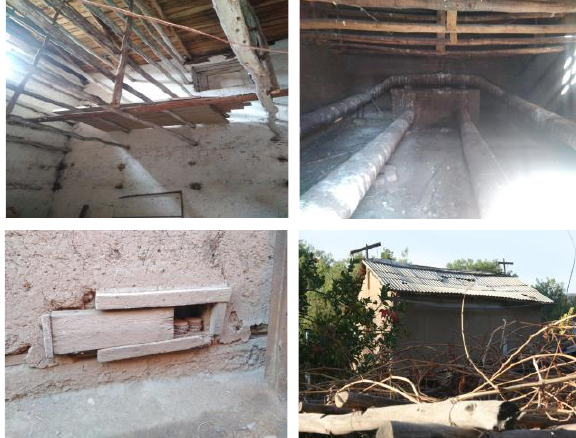
Figure 2. Mechanical features designed to enhance tobacco drying. a. Poplar logs were used to hang tobacco leaves b. Iron tubes conducted hot air through the furnace c. Wooden portholes controlled air intake in the furnaces d. Ridges could be lifted mechanically to allow for better ventilation.